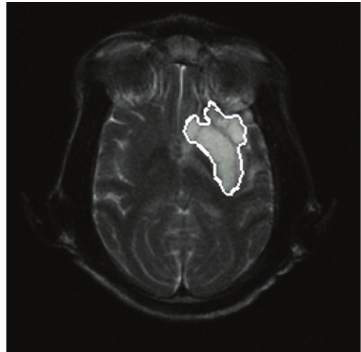
Figure 1: 0h after MCAO DWI shows high-signal ischemic lesion.